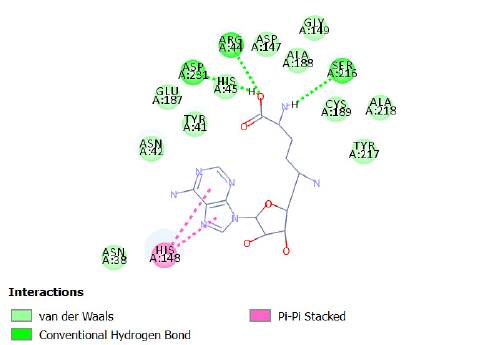
Fig. 5A. 2D diagram showing interactions of sine- fungin at LGMN catalytic site.